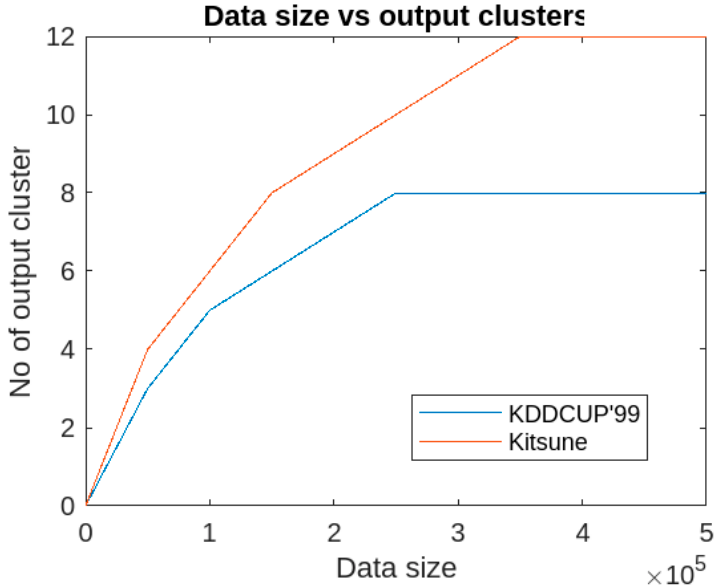
Figure 5. Data size vs. output clusters using KDDCUP’99 and Kitsune.